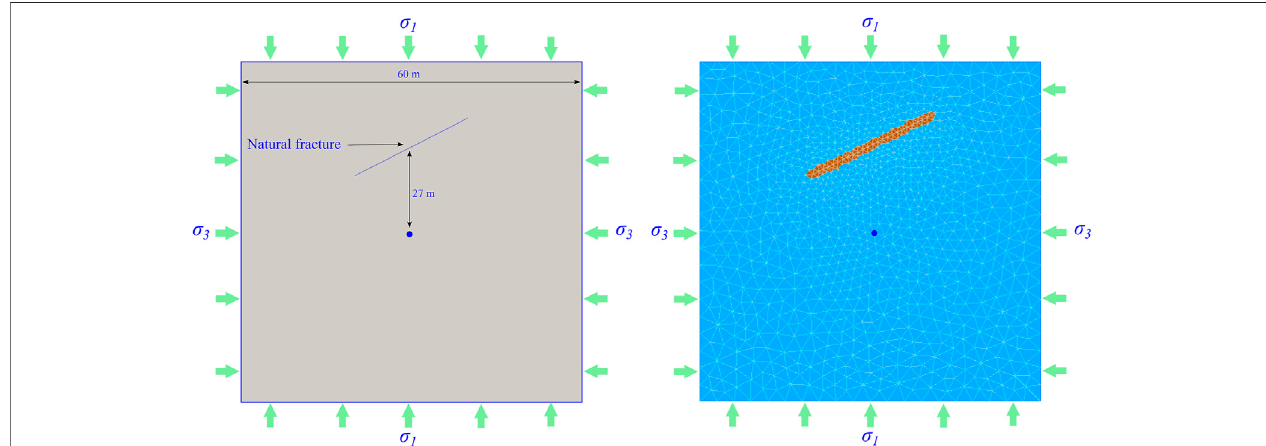
FIGURE 5 | Numerical model for case 1. (A) Geometry model; (B) meshing.